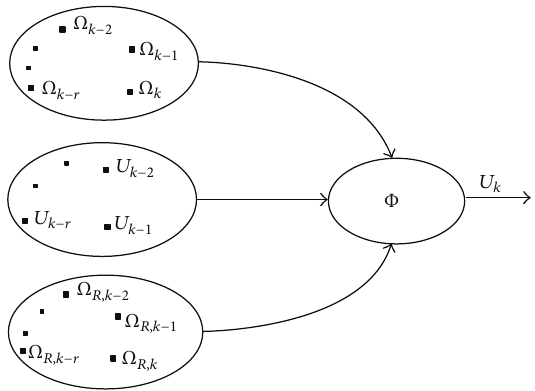
Figure 3: Memory-based pitch